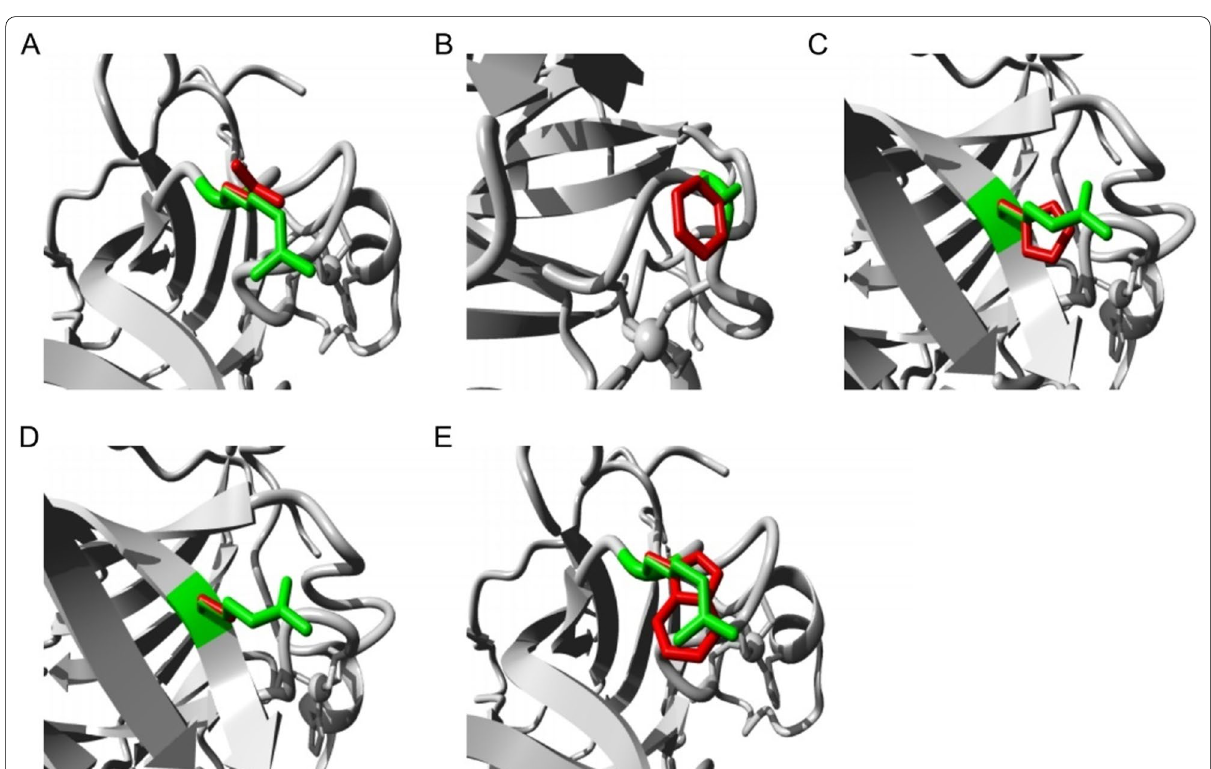
Fig. 4 Effect in the structure due to mutation A R248Q, B S241F, C R273H, D R273C, E 248W (The protein is colored gray, green indicates the side chains of wild type, and mutant residue is shown in